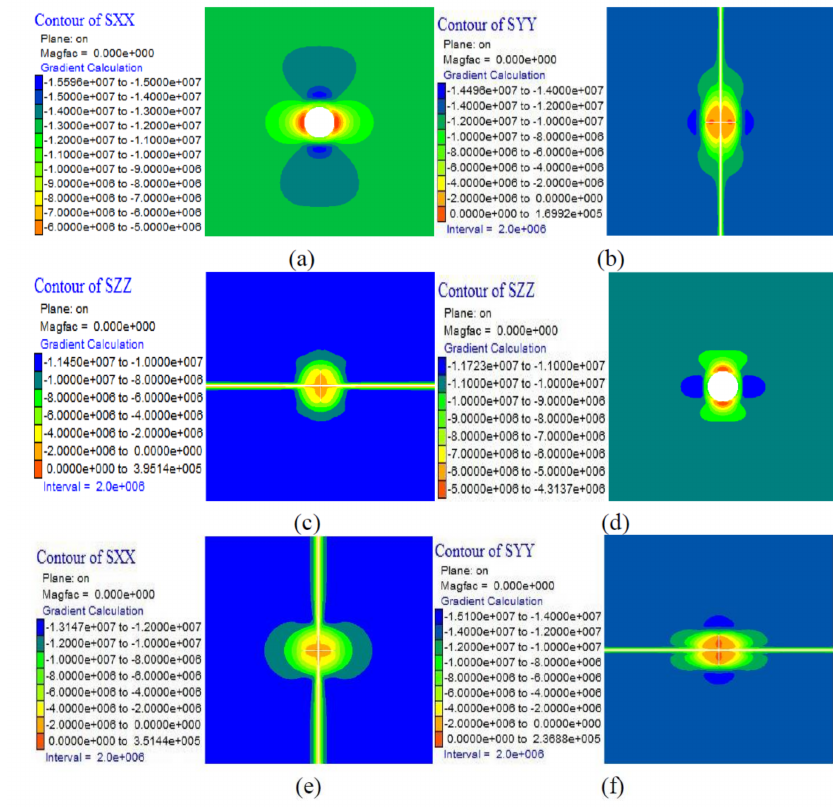
Figure 11. Stress distribution of a single slot: ( a ) Stress distribution profiles of sections 1 in the X directions; ( b ) Stress distribution profiles of sections 2 in the Y directions; ( c ) Stress distribution profiles of sections 3 in the Z directions; ( d ) Stress distribution profiles of sections 1 in the Z directions; ( e ) Stress distribution profiles of sections 2 in the X directions; ( f ) Stress distribution profiles of sections 3 in the Y